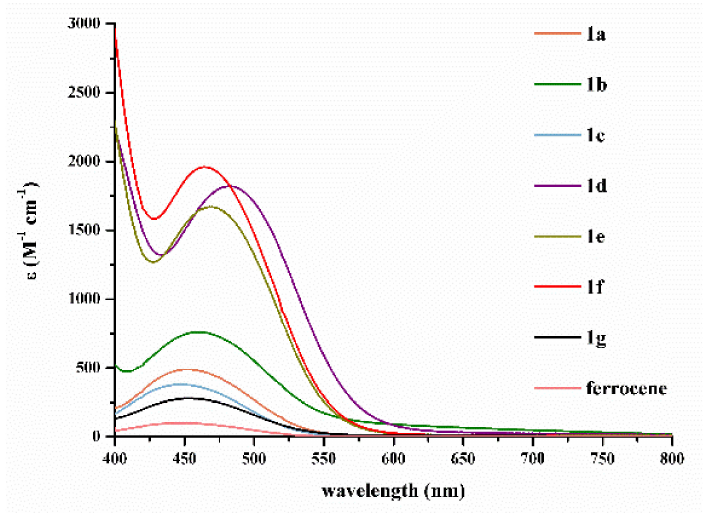
Figure 2. Absorption spectra of ferrocene-based compounds 1a–g in